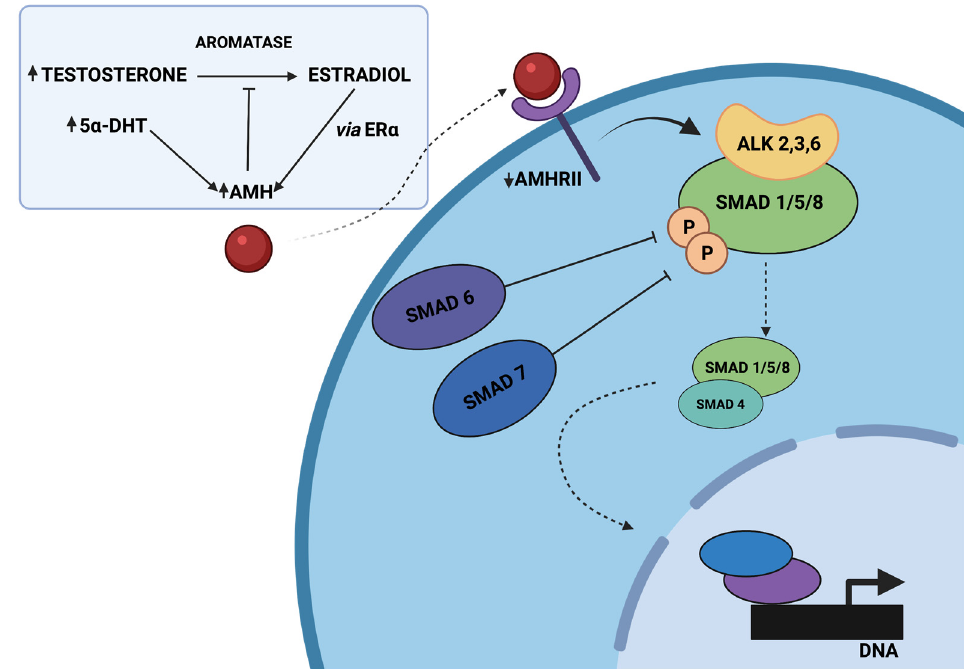
Figure 2. The proposed model of disrupted AMH signaling in women with PCOS, adapted from Dilaver et al. [120]. Hyperandrogenism inhibits the decrease in AMH levels directly by elevated 5 α -dihydrotestosterone (5 α -DHT) levels or indirectly through the conversion of testosterone to estradiol and the increased expression of ER α . Elevated AMH levels might diminish the expression of aromatase and increase the protein levels of the inhibitory SMADs (SMAD-6, SMAD-7), associated with negative regulation of intracellular SMAD signaling. It might disrupt pSMAD-1/5/8 binding to SMAD-4 and, as a consequence, alter the expression of various genes. Created with BioRender.com.